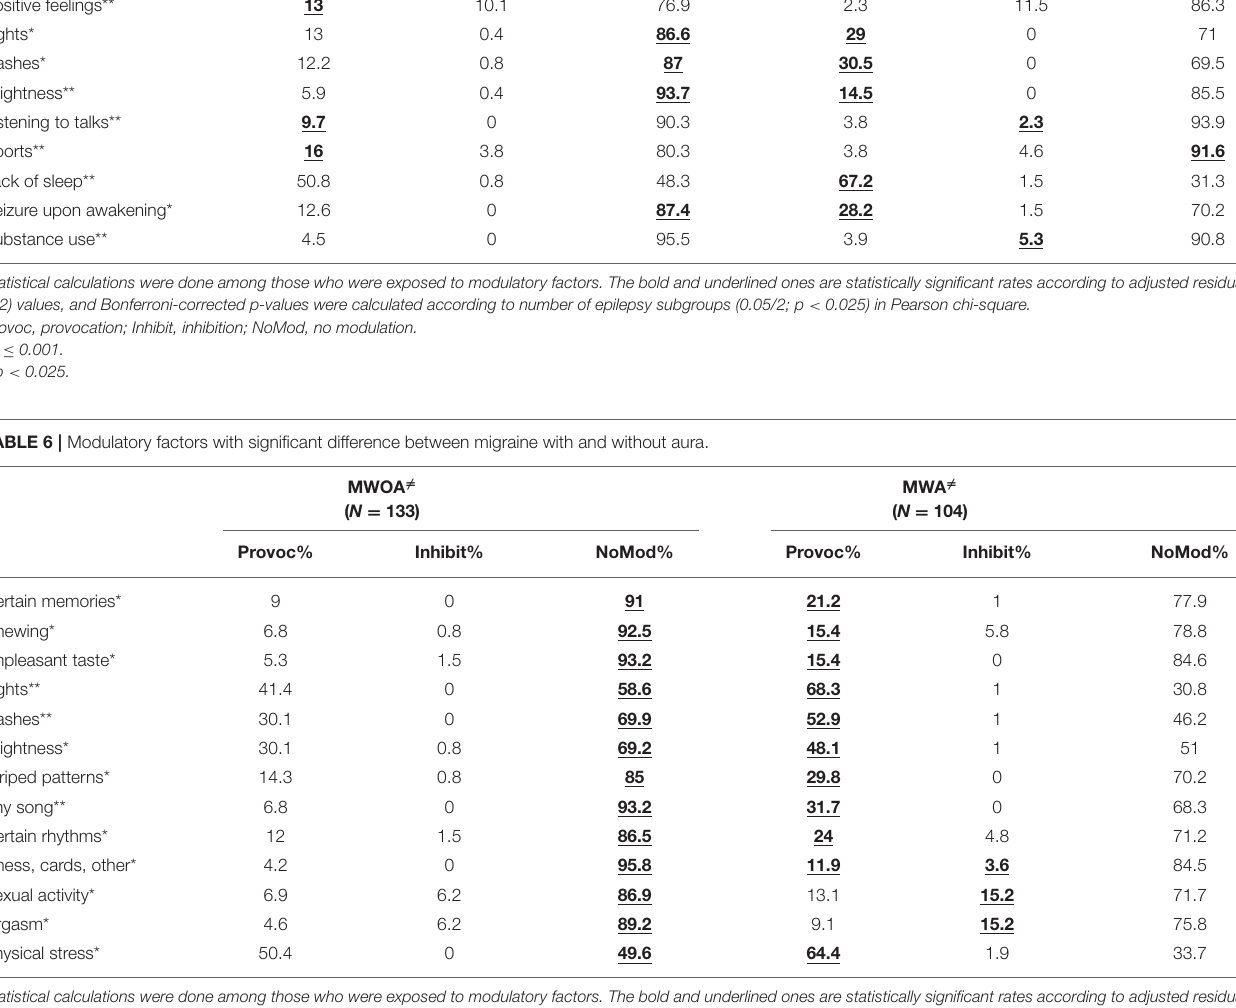
Statistical calculations were done among those who were exposed to modulatory factors. The bold and underlined ones are statistically significant rates according to adjusted residual ( ≥ 2) values, and Bonferroni-corrected p-values were calculated according to number of migraine subgroups (0.05/2; p < 0.025) in Pearson chi-square. MWOA, migraine without aura; MWA, migraine with aura; Provoc, provocation; Inhibit, inhibition; NoMod, no modulation. 6= Two uncertain diagnosis in the migraine group. * p < 0.025. ** p ≤